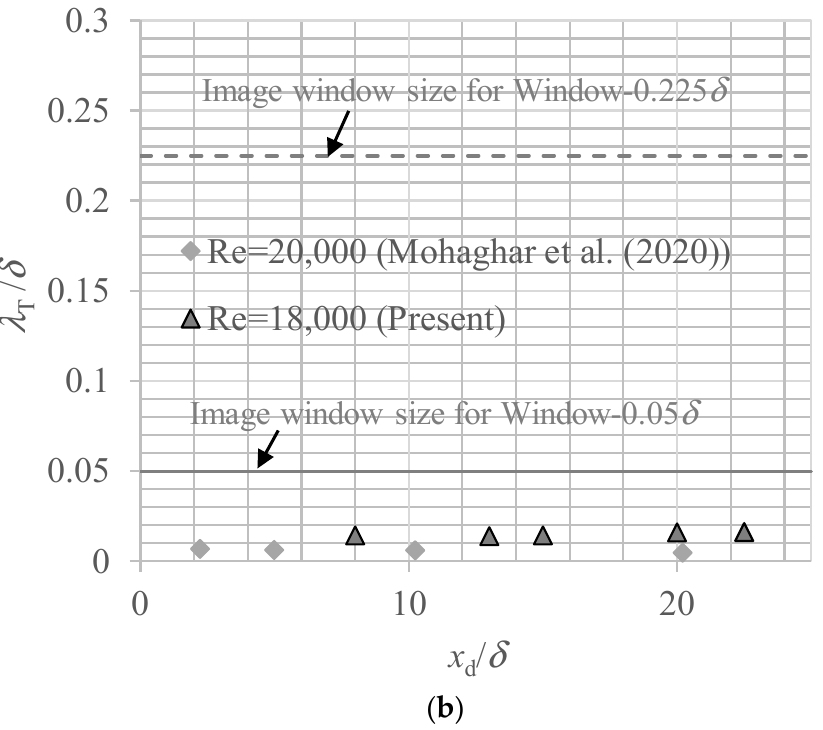
Figure 4. Length scale related to fluctuated scalar concentration field as a function of the distance from the scalar source: ( a ) integral length scale, L , and ( b ) scalar Taylor microscale, λ T . As mentioned earlier, from the point source to a medium distance, the concentration mass was distributed not uniformly over the entire channel, resulting in macroscopic concentration non-uniformity. To identify the range of source distance where this non- uniformity affects the accuracy of determination, the distance that the dye flows from the channel center to spread over the entire channel was estimated. The spanwise wavelength of large-scale structures in the channel turbulence is 1.3 δ –1.6 δ [30], and it is assumed that the dye in the channel center is directed toward the wall vicinity, owing to the vortices related to this large-scale structure and the smaller-scale vortices. Assuming that the advection velocity from the channel center to the wall vicinity is about the same as wall-normal velocity fluctuation, v’ , the arrival time from the channel center to the wall surface, t h , is t h ≈ δ / v (cid:48) Assuming that the speed at which the dye advances in the streamwise direction is about the same as the bulk velocity, u b , the distance of x h traveled in time of t h is x h ≈ u b × t h = δ u b / v (cid:48) . According to DNS database [30], u b / v’ = 15–20 for Re τ = 180–640. Then, x h at Re b = 18,000 was estimated as follows: